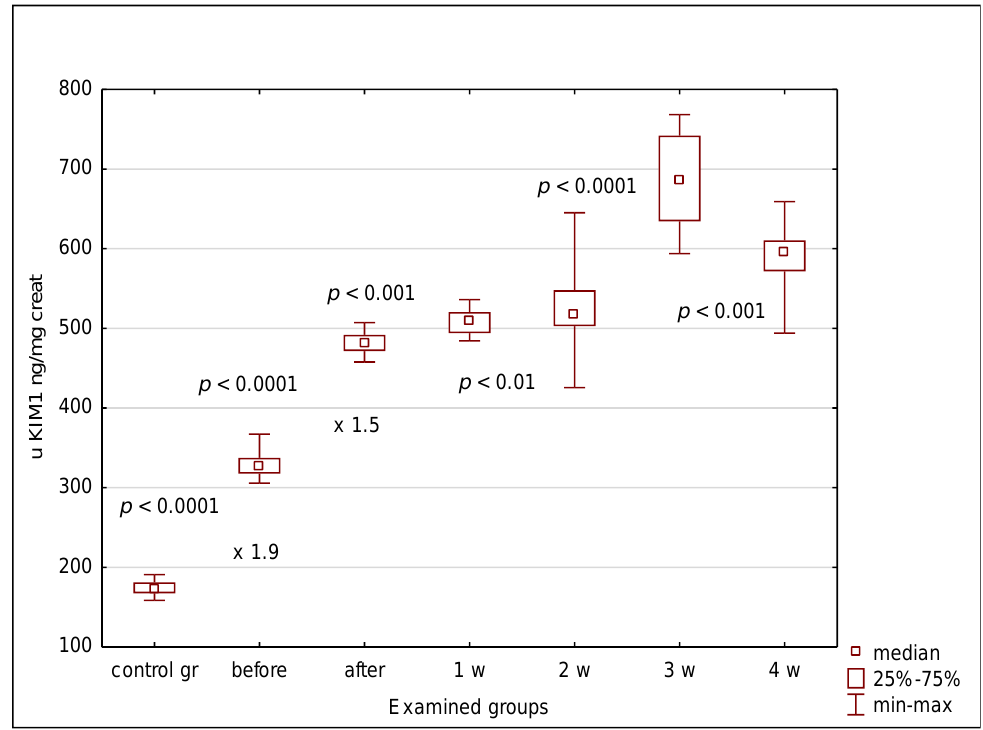
Figure 3. Urinary KIM-1 values in examined groups. before—before alloHSCT; after—24 h after alloHSCT; 1 w (2 w, 3 w, 4 w)—1 week (2, 3, 4 weeks) after alloHSCT.